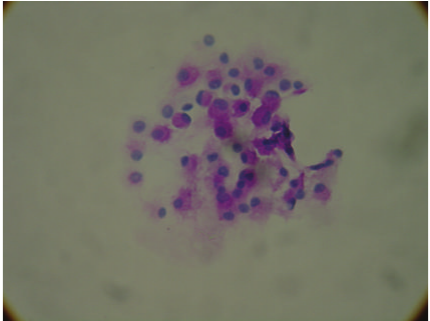
Figure 3: A Periodic acid-Schiff (PAS) stain showing adenocarci- noma cells with pink staining of mucin in the